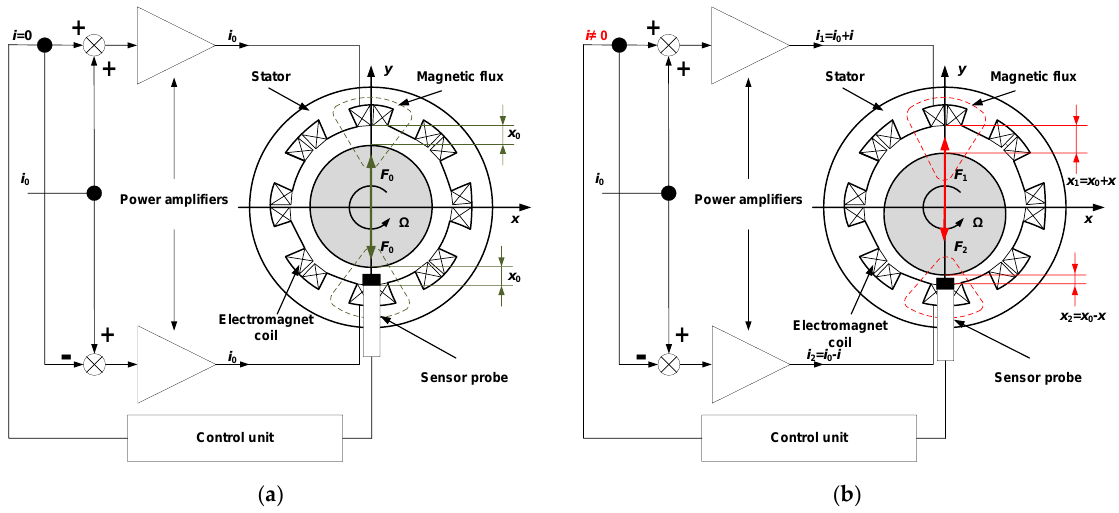
Figure 2. Active magnetic suspension: rotor in the operation point ( a ), rotor outside of the operation point ( b ).